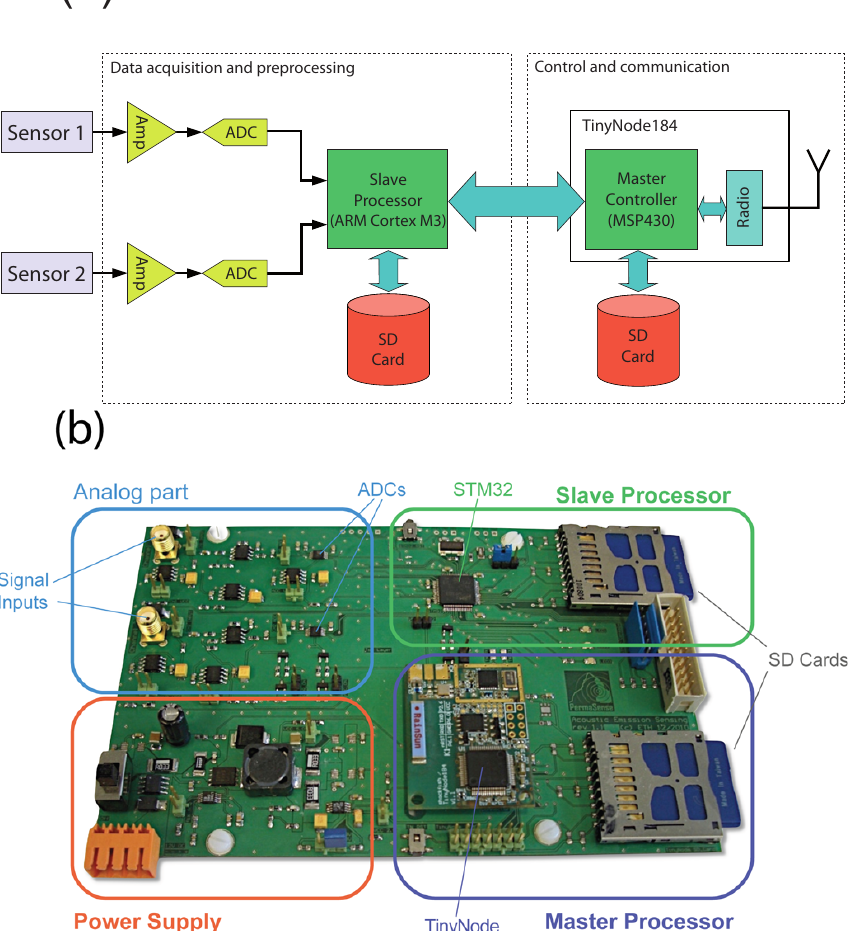
Fig. 2. (a) Block diagram of AE-node architecture and (b) electronic board.